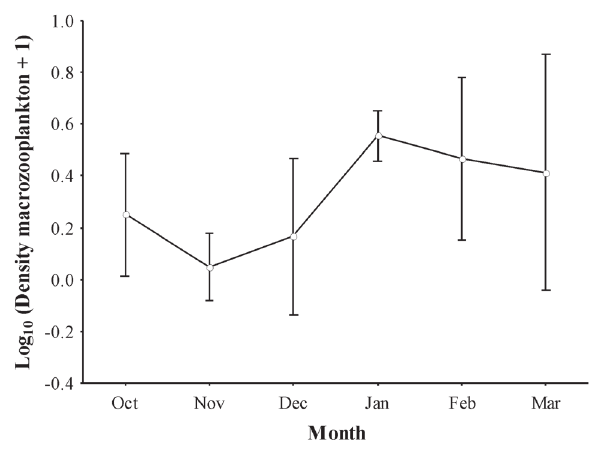
Fig. 6. Average density ± standard deviation of the macrozooplankton organisms captured in both environments (rapids and pool) of the Peixe River, between October 2011 and March 2012.